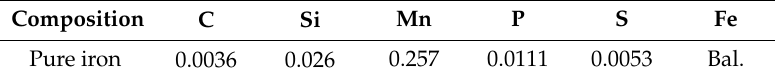
Table 1. Chemical composition of pure iron in this study. Composition C